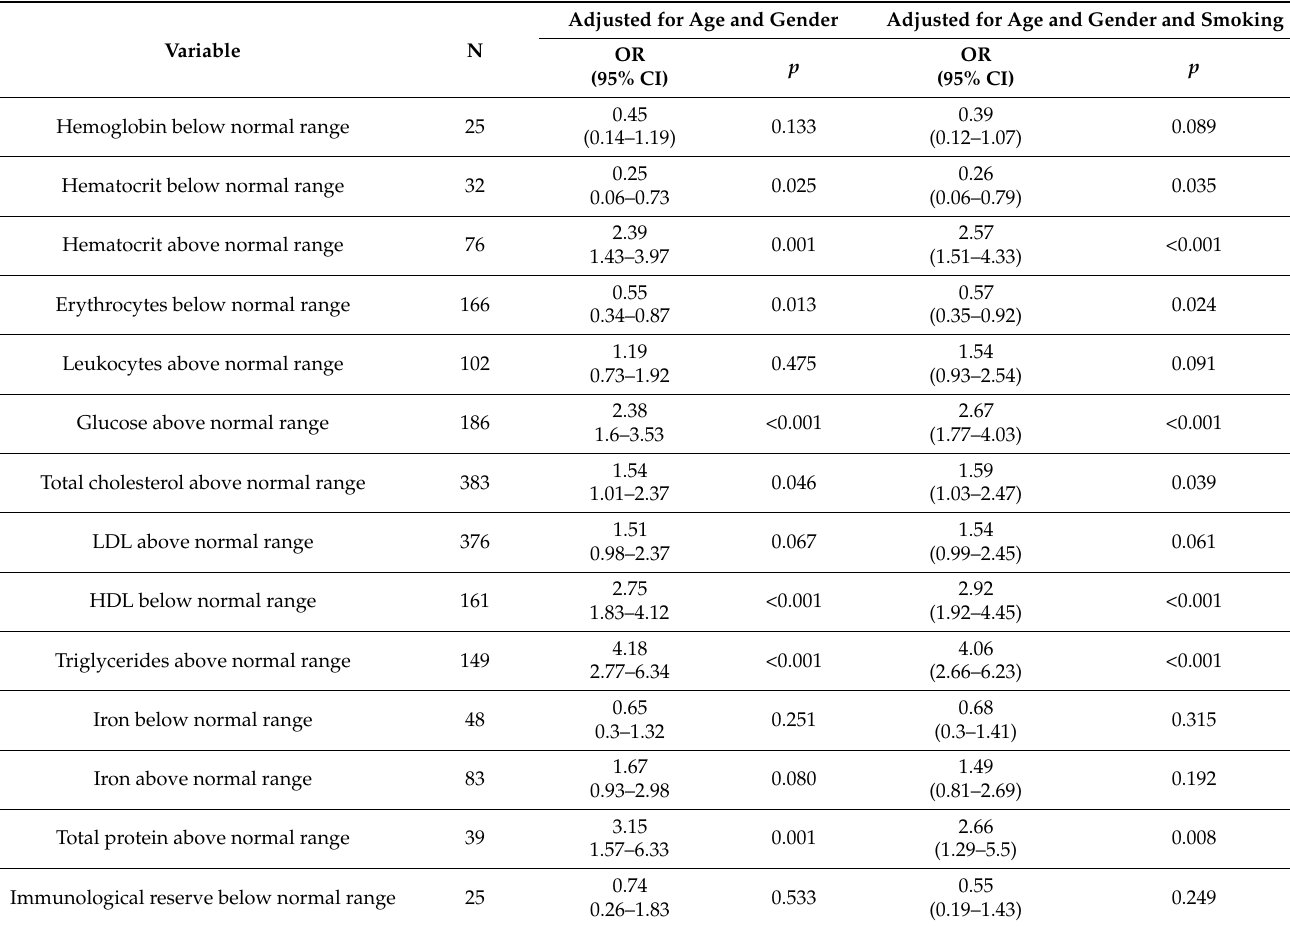
Table 6. Odds ratio for abnormal blood markers adjusted for age, gender, smoking.